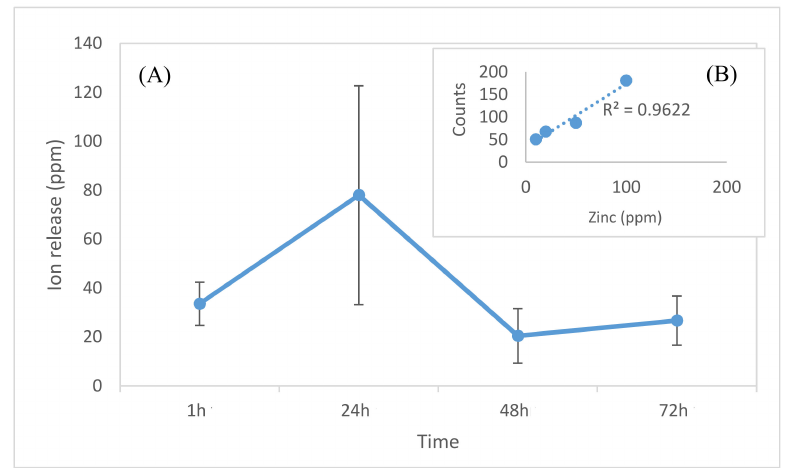
Figure 11. ( A ) Zinc ion release from the CS-ZnHNTs-GS coatings; highest ion release concentration was observed at 24 h ( n = 5), ( B —zinc ion standard X-ray fluorescence (XRF)